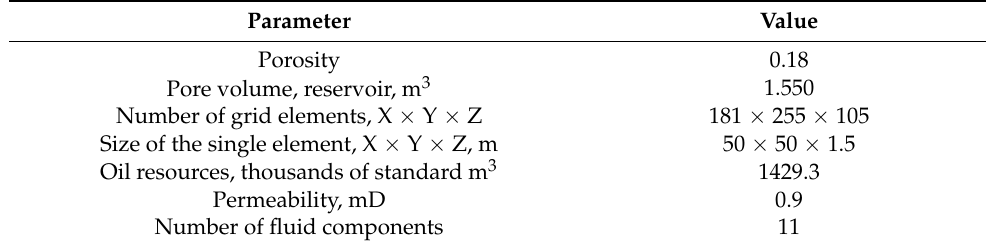
Table 4. Hydrodynamic model